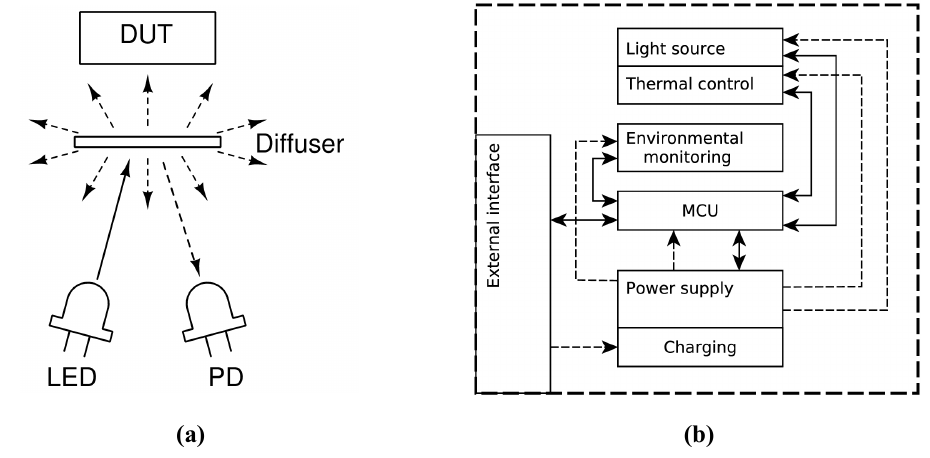
Figure 24. (a) General optical design concept of the IN-SITU-SC. DUT—optical entrance of the device under test, PD—feedback photodiode. Solid arrows denote the radiant flux from LED to the diffuser, dashed arrows mark the flux scattered from the diffuser. (b) Subsystem module diagram for the portable stability-monitoring device, with electrical connections shown with dashed lines, data connections with solid lines.